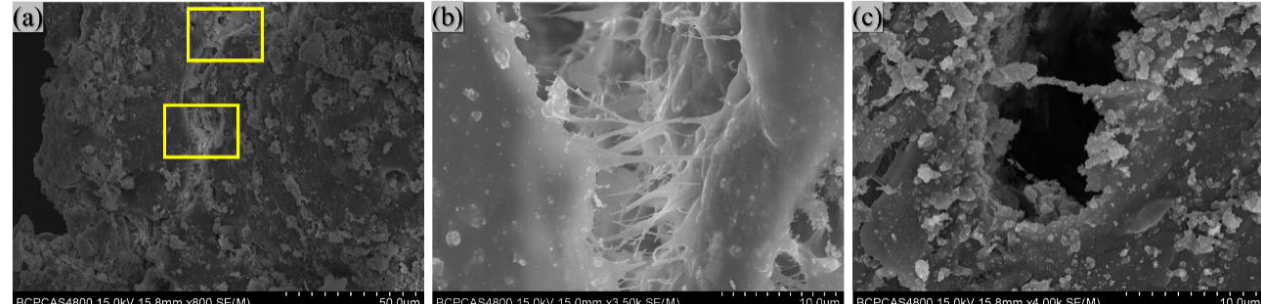
Figure 12. SEM photograph of crack: ( a ) crack; ( b ) edge of the crack; ( c ) tip of the crack. When impacted by the falling hammer, the material is first violently deformed, the particles are extruded and rubbed against each other during the deformation, the pores in the material collapse and close, and the particles and the PTFE matrix are de-bonded. A